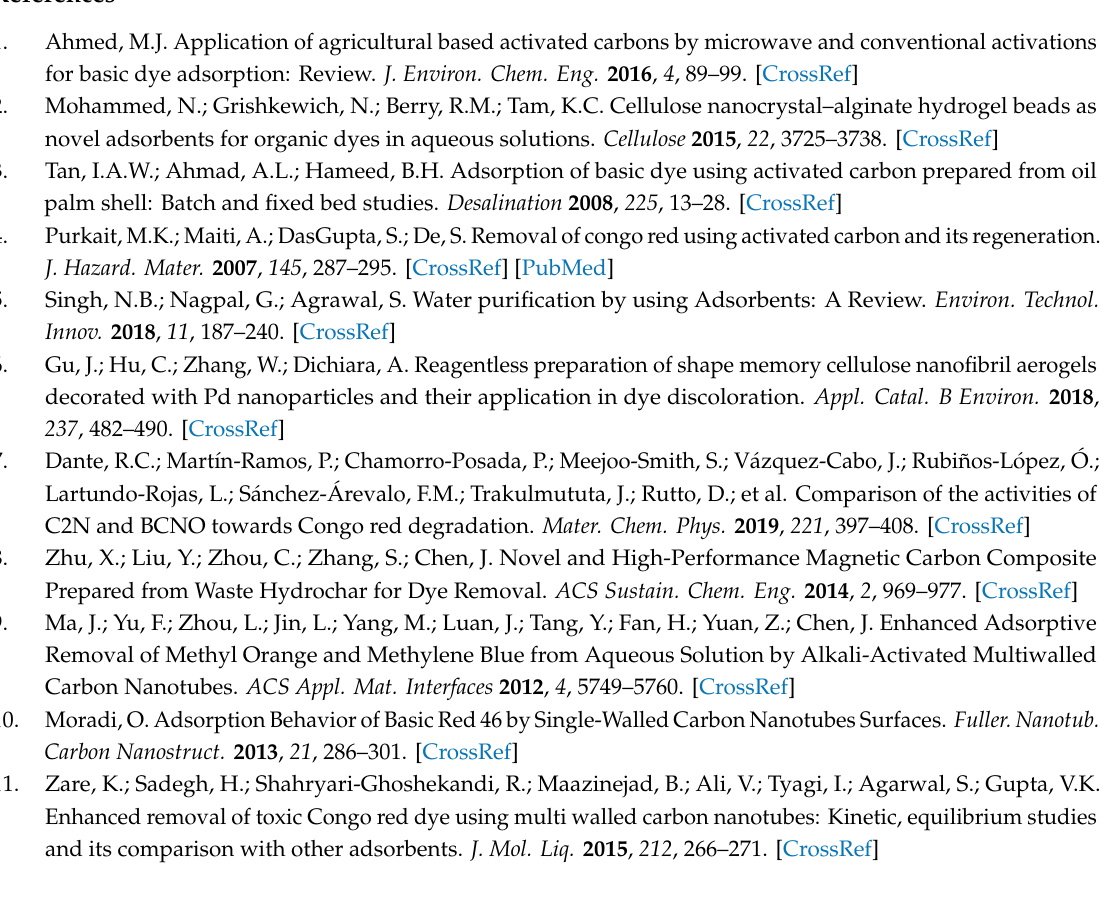
Figure S1: Conductometric titration curves of CNF (a) with HCl added and (b) without HCl added., Figure S2: Optical micrographs of (a) CNF / CNT 3:1 after 5 min ultrasonic treatment; (b) CNF / CNT 3:1 after 30 min ultrasonic treatment; and (c) CNF / GnP 3:1 after 5 min of ultrasonic treatment; (d) CNF / GnP 3:1 after 30 min ultrasonic treatment, Table S1: Chemical structure, molecular weight, maximum absorption wavelength and electrical property of methylene blue and Congo red. Table S2: Group statistics of the final adsorption of MB. Table S3: Independent sample tests of the final adsorption of MB onto CNF–GnP 3:1 and CNF–CNT 3:1. Table S4: Group statistics of the final adsorption of CR. Table S5: Independent sample tests of the final adsorption of CR